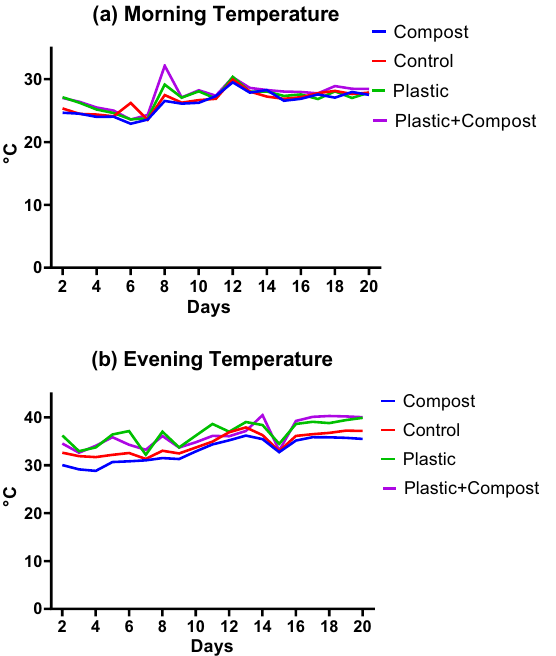
Fig. 1 Temperature variation patterns in solarized soils